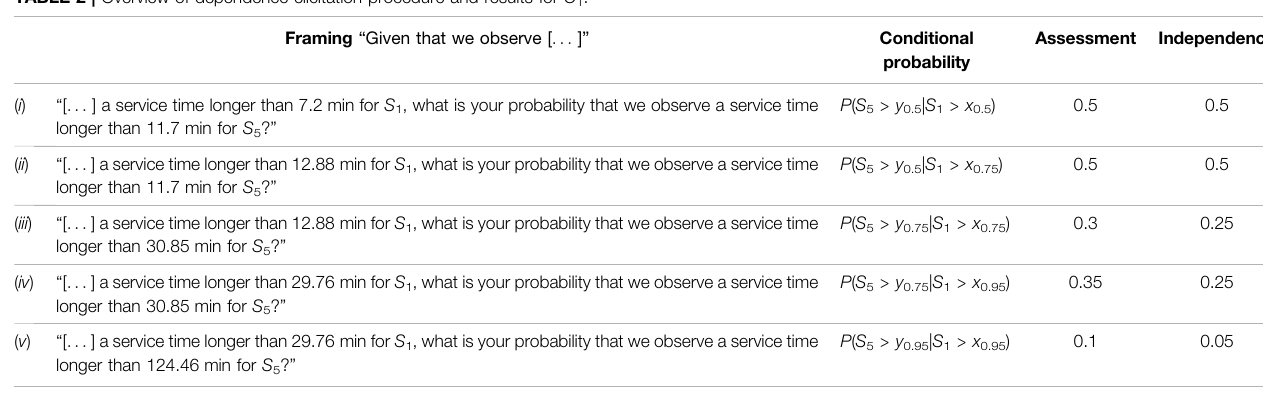
TABLE 2 | Overview of dependence elicitation procedure and results for C 1 . Framing “ Given that we observe [ ... ]